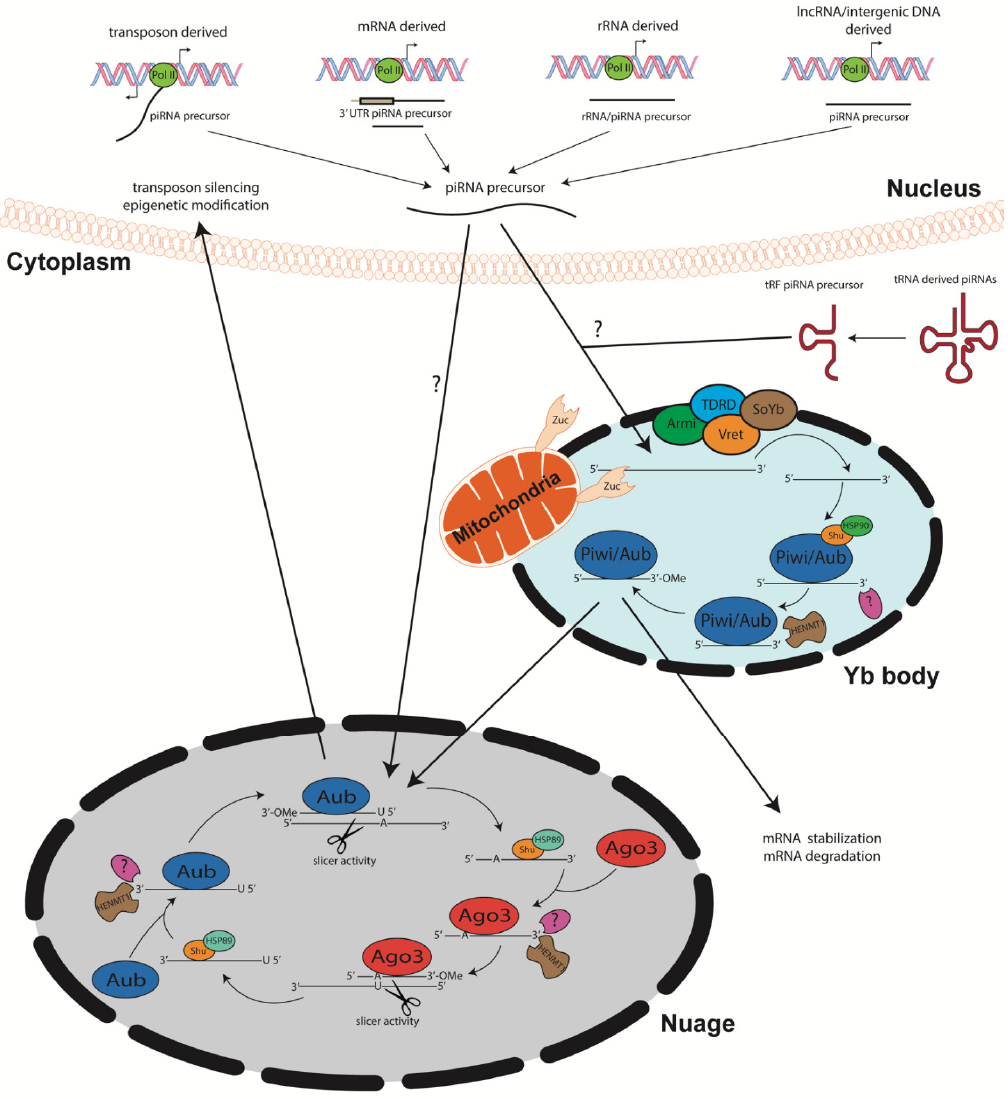
Figure 1. piRNA biogenesis Precursor piRNAs within the nuclear compartment are generated from sense and antisense transposon sequences, 3 (cid:48) UTR of messenger RNAs (mRNAs), ribosomal RNAs (rRNAs), long noncoding RNAs (lncRNAs) and intergenic DNA sequences. Furthermore, piRNAs can be derived from transfer RNA (tRNA), specifically transfer RNA related fragments (tRFs) that are processed in the cytoplasm. During primary biogenesis within the Yb body (shown to occur in somatic cells) precursor piRNA is associated with various processing proteins including Tutor domain containing protein (TDRD), Armitage (Armi), Vreteno (Vret), and Sister of Yb (SoYb), though their specific functions during piRNA biogenesis is not well understood. piRNA precursors are processed by mitochondria membrane bound protein Zucchini (Zuc) into small segments. Shutdown (Shu) and Heat shock protein 90 (HSP90) shuttle piRNAs onto Piwi proteins. An unknown endonuclease further processes the 3 (cid:48) end of the piRNA before piRNA methyltransferase Hen1 (HENMT1) adds a 3 (cid:48) -OMe group. Mature piRNAs enter the ping pong cycle to produce progeny piRNA, re-enter the nucleus for transposon silencing and epigenetic modification, or enter the cytoplasm to play roles in mRNA transcript stabilization or degradation. The ping-pong cycle occurs in the Nuage (shown to occur in germ cells), where antisense piRNAs bound to Aubergine (Aub) can bind to sense piRNA precursor molecules, allowing the RNAse H-like slicer activity to process the precursor piRNA into a smaller segment. Shu and HSP89 shuttle processed piRNAs onto Argonaute 3 (Ago3). An unknown protein processes the 3 (cid:48) end, and subsequently HENMT1 adds the characteristic 3 (cid:48) -OMe that is required for piRNA stabilization. Mature, sense, Ago3 bound piRNAs can continue to process more antisense precursor piRNAs that will bind to Aub and continue the cycle of piRNA secondary biogenesis. The mature, stable piRNAs synthesized from the ping-pong cycle can then enact various piRNAs function in the nucleus and/or in the